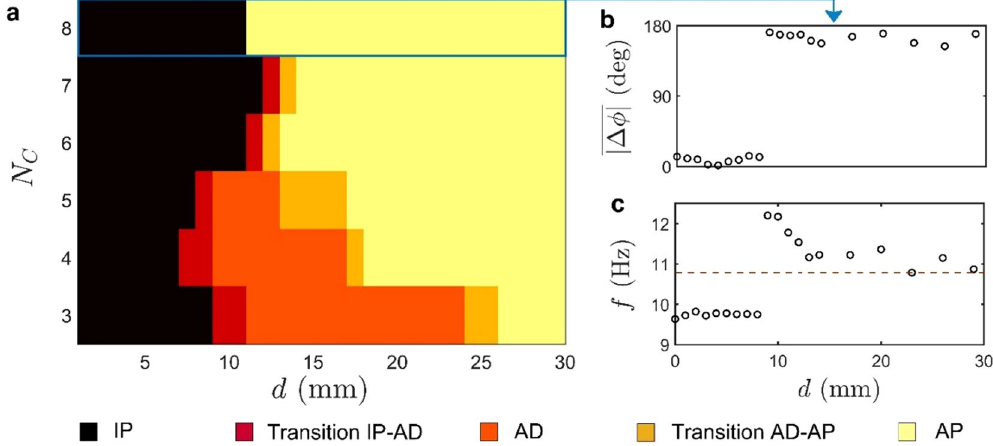
Figure 4. A two-parameter bifurcation plot between N and d depicting the coexistence of AD and PFB in the C dynamics of coupled candle-flame oscillators. (a) The mapping of the occurrence of various states of coupled dynamics in a pair of candle-flame oscillators with variation in two control parameters, d and N . N is varied C C from 3 to 8, while d is increased from 0 to 30 mm in steps of 1 mm. ( b , c ) The variation in the time averaged value of absolute relative phase and the dominant frequency, respectively, with d for a pair of candle-flame = 8, highlights the phenomena of PFB. With increase in N oscillators consisting of N , the region of AD c C gradually reduces to zero leading to the onset of PFB in the parameter space of d . The dominance of the AD or PFB exhibited by the system is decided by the control parameter N . At lower N , AD dominates whereas at C C higher N , PFB prevails. These observations of PFB along with AD in the same physical system of coupled C candle-flame oscillators can be qualitatively replicated in a theoretical model of delay coupled identical Stuart- Landau oscillators (refer for further information to Supplementary Note 1 and Supplementary Figs.